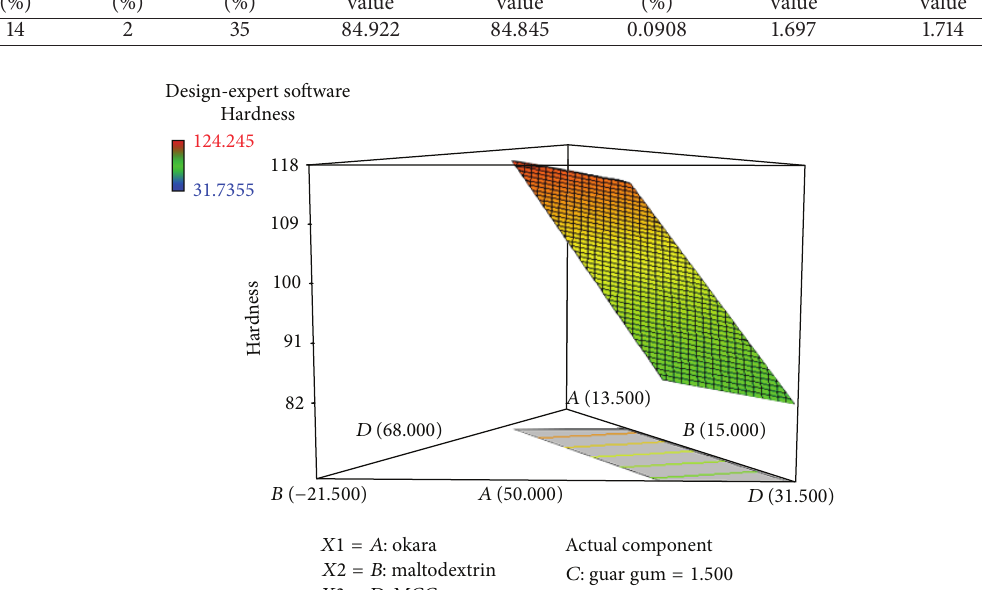
Figure 2: 3D diagram of relationship between three variables, ( 𝐴 ) percentage of okara, ( 𝐵 ) percentage of maltodextrin, and ( 𝐷 ) percentage of Avicel PH-101, and with actual component of guar gum ( 𝐶 = 1.50 %) to the hardness of the tablet.